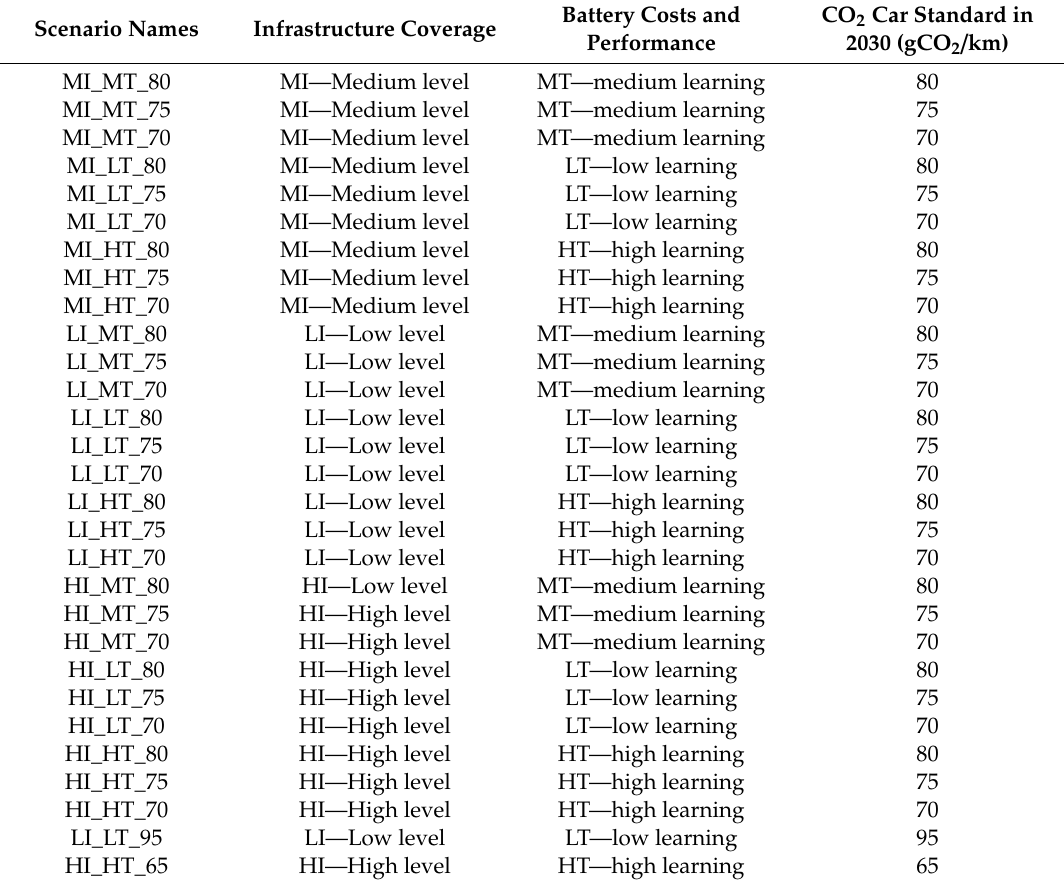
Table 3 defines sensitivity scenarios as combinations of policy intensity for infrastructure, battery cost reduction and CO 2 car standards. The table also shows the scenario acronyms. Table 3. Overview of scenario